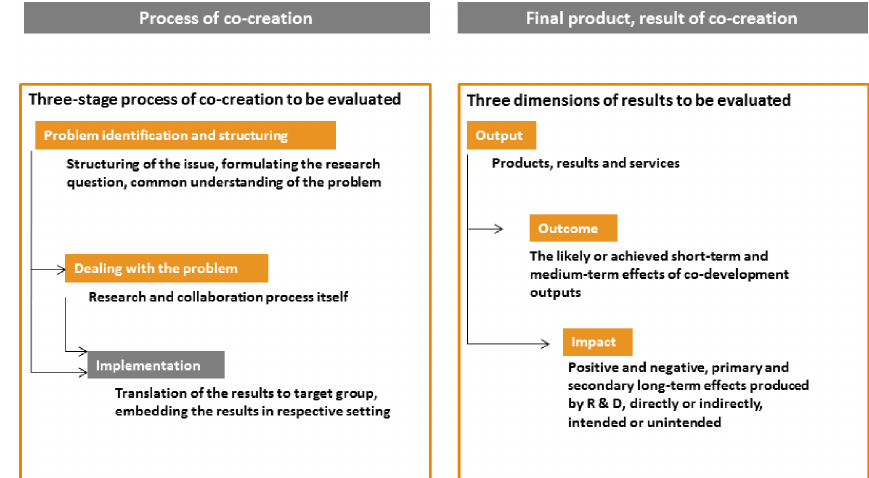
Figure 2. The process of co-creation (on the left) spreads up into three consecutive phases (Pohl and Hirsch Hadorn, 2007), each of them can be evaluated. In terms of product or result of this process, either the “output”, or “outcome” or the “impact” (OECD, 2002) might be assessed. Describing texts adapted to the issue by the authors.